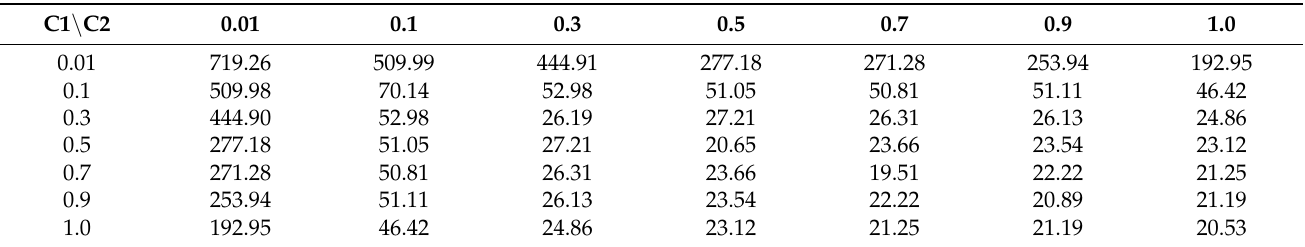
Table 3. The membrane impedance R s+m ( Ω cm 2 ) at electrolytes C1 and C2 (M) on both sides of the membrane, as measured by DC chronopotentiometry.